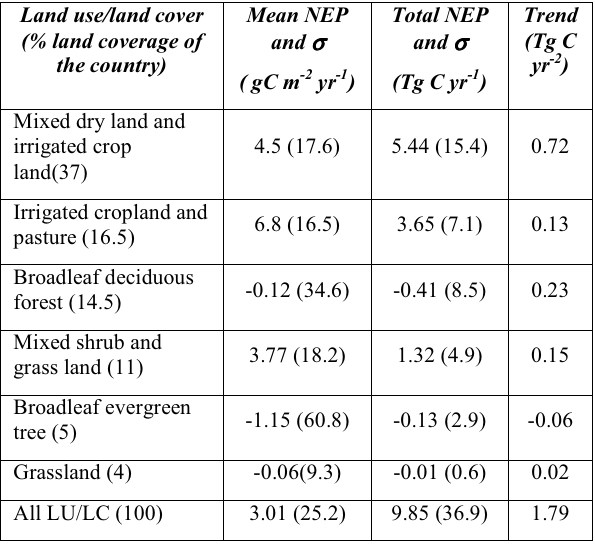
Table 1: Statistics of annual NEP climatology and long-term linear growth rate of total NEP over major land cover types in